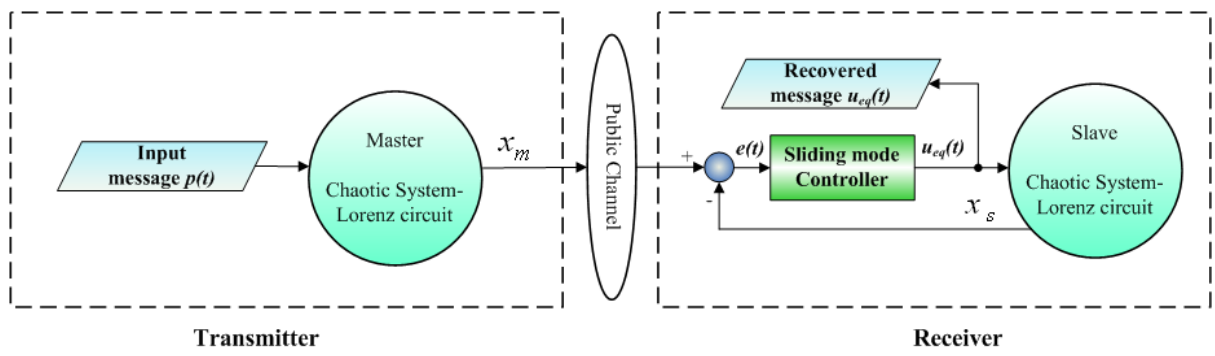
Figure 1. Block diagram of SMC-based scheme secure communication